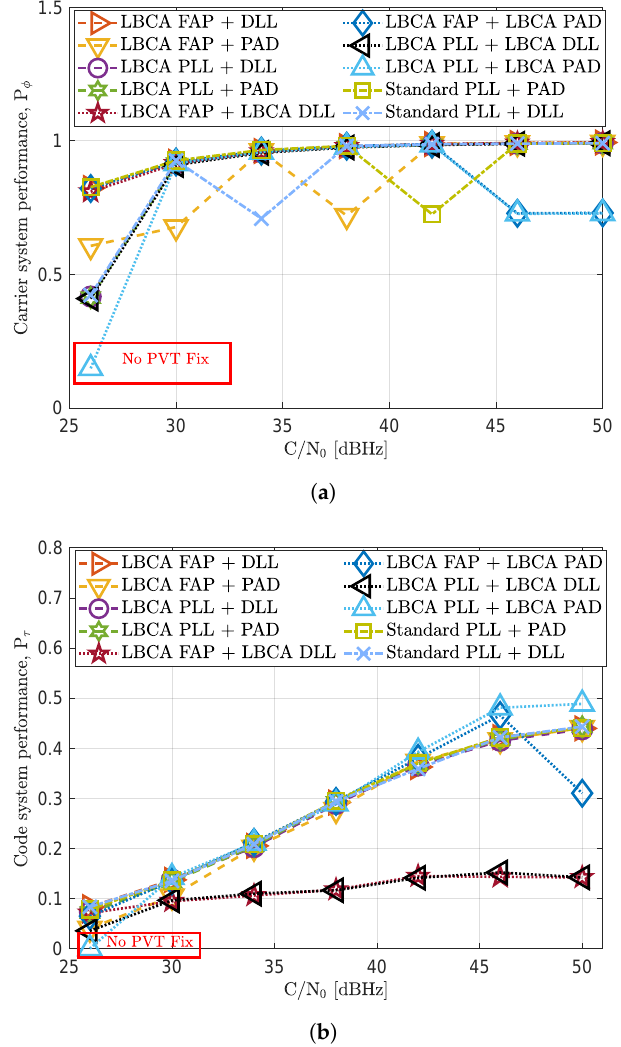
Figure 10. System performance evaluation in static scenario. ( a ) Carrier system performance. ( b ) Code system